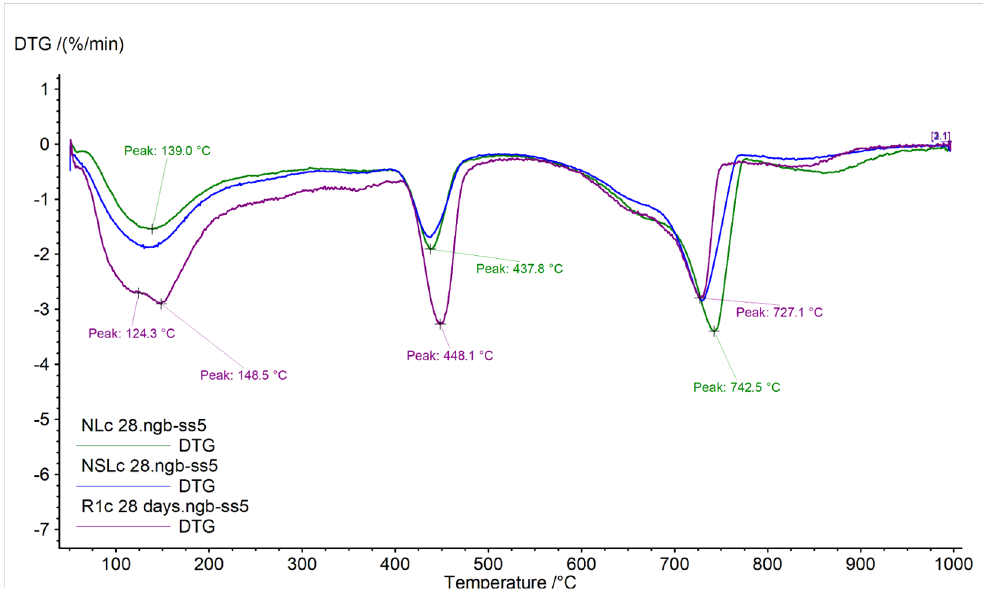
Figure 5. DTG curves of neat cement paste and nano-modified cement pastes cured under wetting-drying cycles at 28 days. Table 4. Calcium hydroxide and carbonate species content, as a percentage by mass, at 28 days.